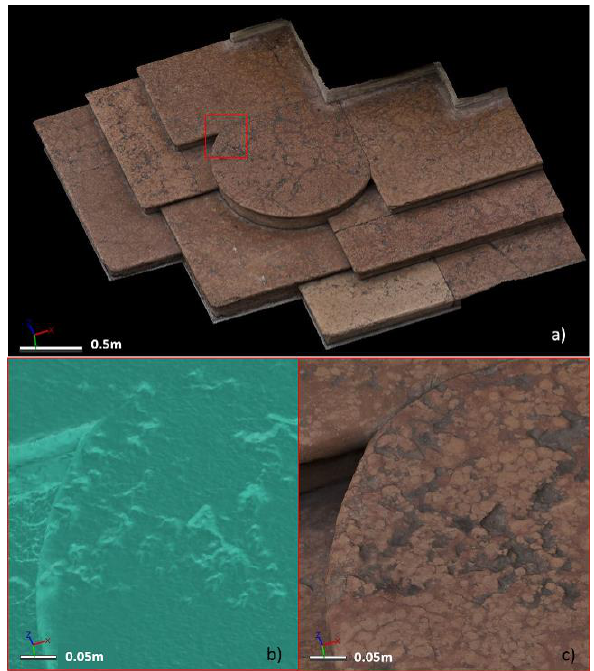
Figure 11 . East side of the basement; the numerous scans acquired (top); the complete photo-textured mesh (bottom). Figure 9. The 3D final model: a) the photo-textured mesh of the Similarly to the models referred to the basement, the individual North-West corner composed by about 12 million triangles; b) parts have been one by one georeferenced on the reference and c) detail of the area in the red square of the model, textured system previously created for the whole monument by the respectively with an artificial colour and with photos RGB topographic and TOF laser scanner (about 300.000 triangles).